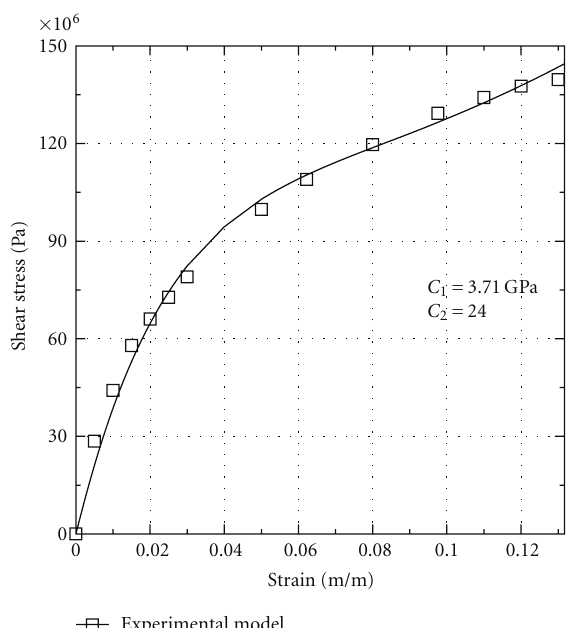
Figure 15: Comparison between numerical and experimental curves for the in-plane shear behaviour.